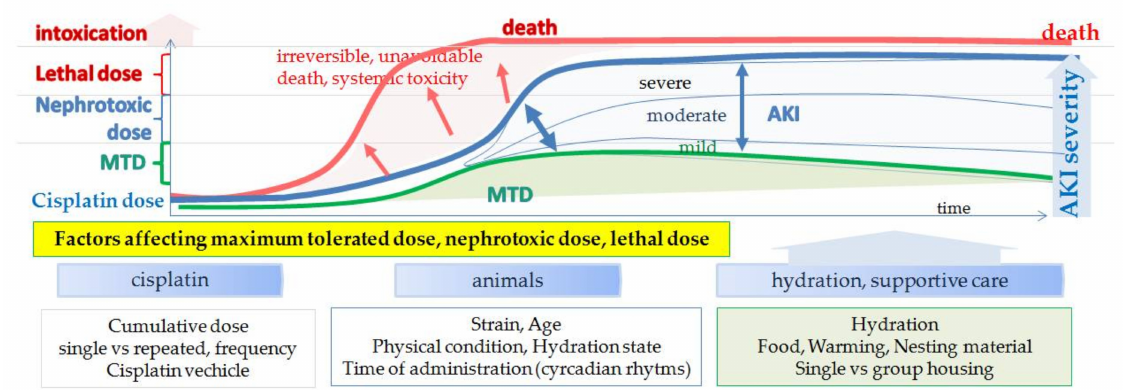
Figure 6. Dose-dependent toxicity of cisplatin and factors affecting maximum tolerated dose (MTD), nephrotoxic and lethal